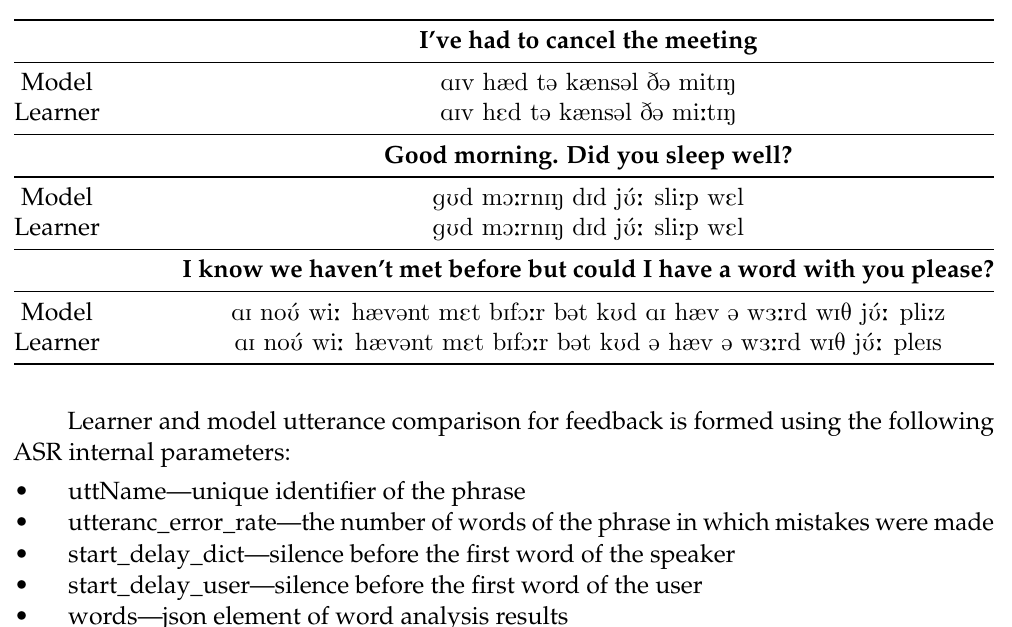
Table 7. Tasks processed by DSPCore for model and